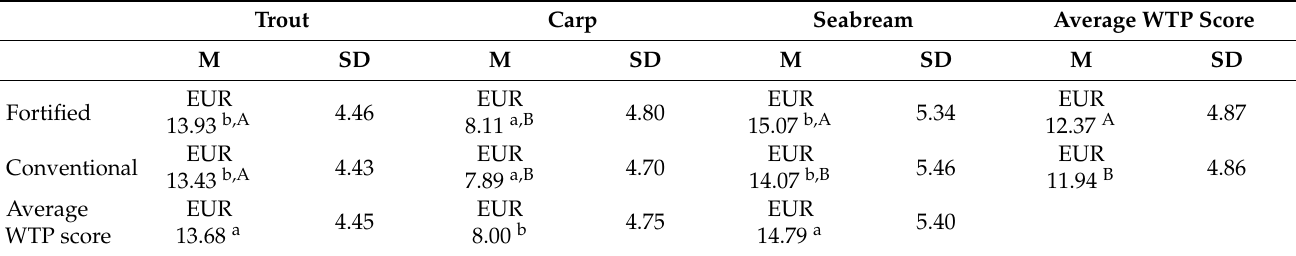
Table 5. Overall WTP for fortified/conventional fish and types of fish 1